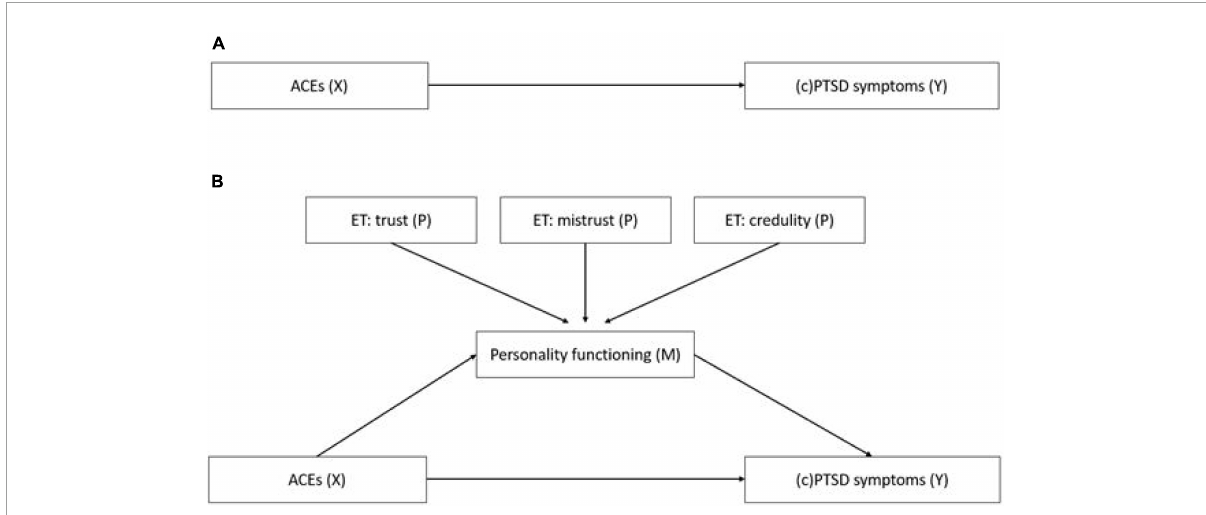
FIGURE1 Structural equation models to test the mediation effect of personality functioning and epistemic trust on the relationship of ACEs with PTSD/cPTSD symptoms in adulthood. (A) Direct association of ACEs (X) and PTSD symptoms (Y). (B) Association of ACEs (X) and PTSD/cPTSD symptoms (Y), mediated by personality functioning (M), which was predicted by epistemic trust (P). Model A depicts the direct association of the independent variable ACEs (X) with the dependent variables PTSD and cPTSD respectively (Y). Model B depicts the model with personality functioning as a mediator (M) and the three epistemic trust subscales as predictors (P) for the mediator